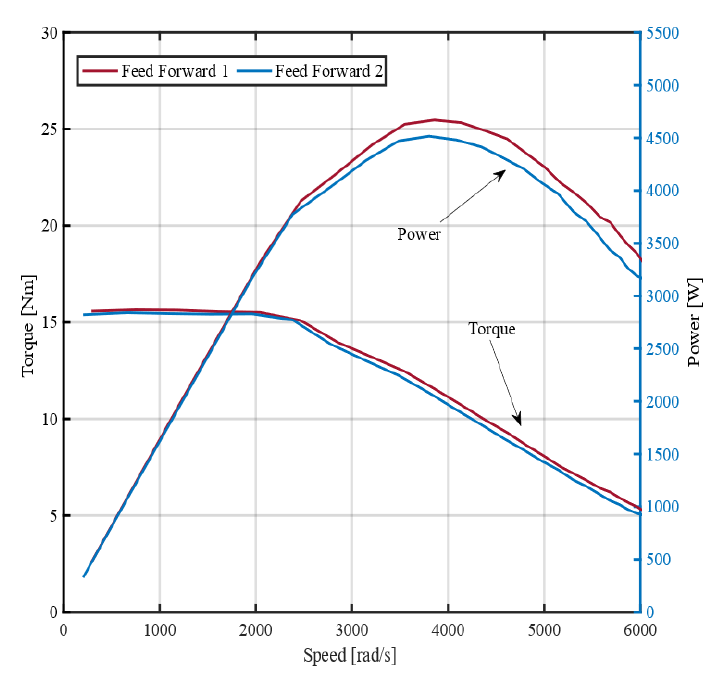
Figure 6. Feed forward results under two different battery voltage estimation. Red line actual battery voltage, blue line voltage underestimated of